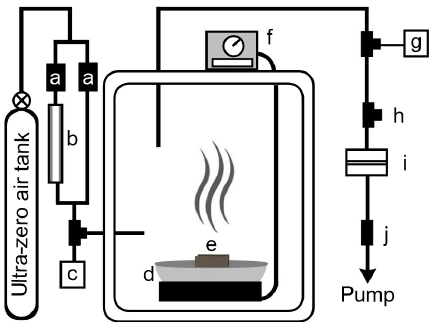
Figure 1. Simplified diagram of smoldering combustion